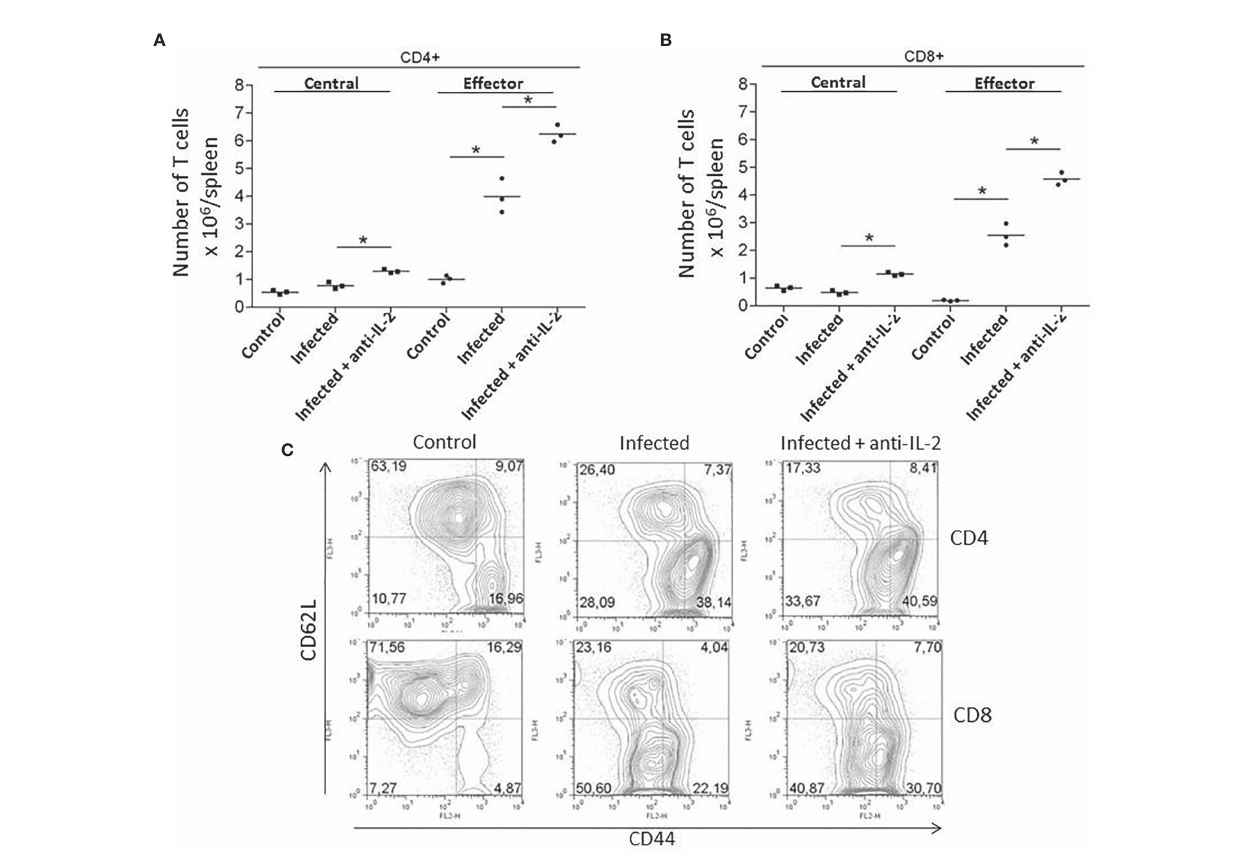
FIGURE 4 | IL-2 blockade increased the numbers of central (CD44 high CD62L high ) and effector (CD44 high CD62L low ) memory T cells during the acute phase of T. cruzi infection. Total numbers of splenic CD4 + (A) and CD8 + (B) central (CD44 high CD62L high ) and effector (CD44 high CD62L low ) memory T cells are compared to infected or uninfected control rat Ig-treated mice. Illustrative FACS plots from one representative experiment, where three pooled spleen cells per group of mice were analyzed, are shown in panel (C) (gated CD4 + T cells, upper plots and CD8 + T cells, lower plots). These experiments were repeated three times with similar results (*P < 0.05, n = 3 group, Mann-Whitney